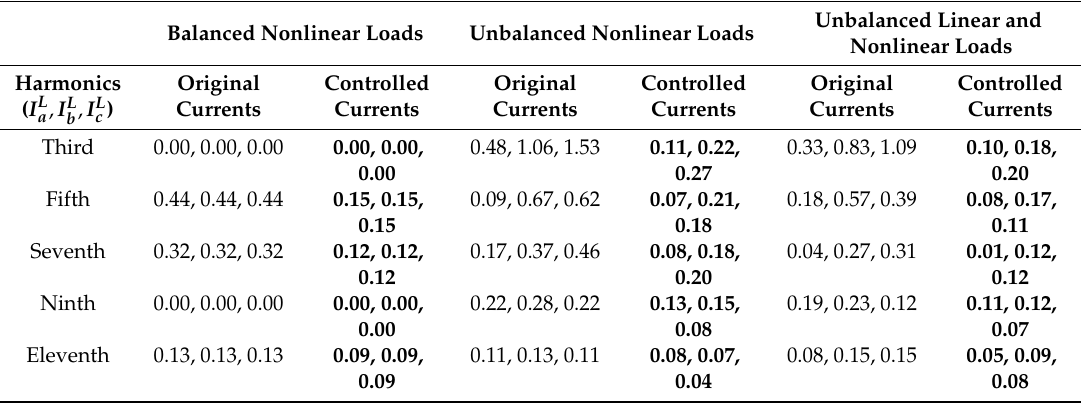
Table 6. Harmonics content attenuated by PI controller driven by GA.